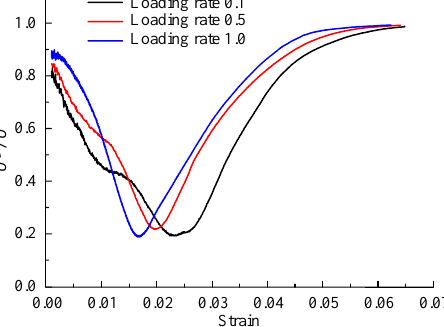
Figure 8. Energy dissipation ratio of specimens with cement/sand = 1:2.